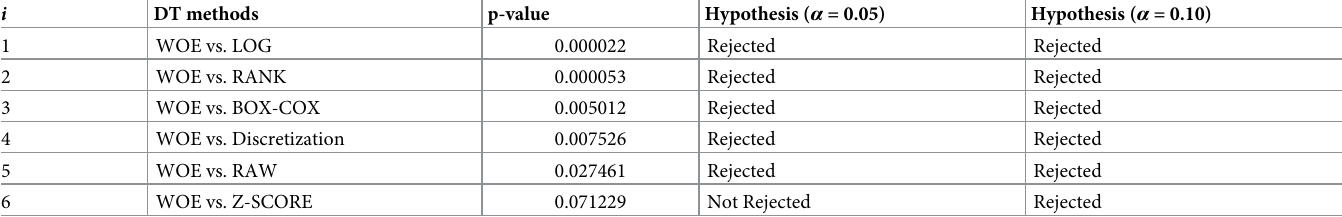
Table 8. Friedman and Holm test